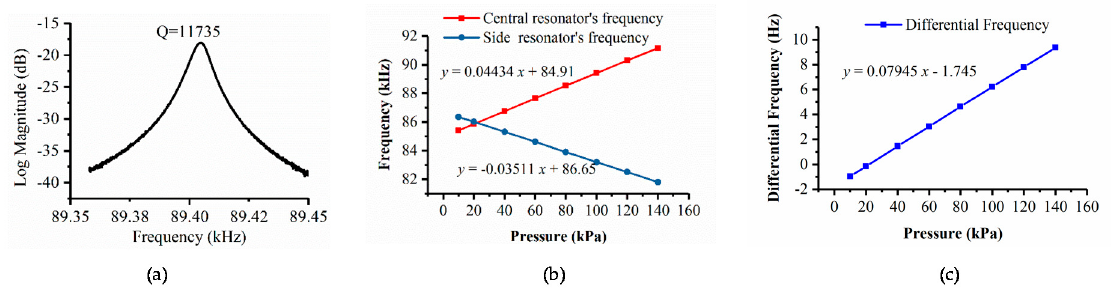
Figure 3. ( a ) The open-loop result of a typical resonant pressure micro-sensor where the quality factor was quantified as 11735, validating the fabrication process, which can produce an environment of high vacuum for the resonators; ( b ) The closed-loop result of a resonant pressure micro-sensor where the resonant frequencies of the central and side resonator were observed to increase and decrease, respectively, in response to an increase in the pressure under measurement; ( c ) The differential output of the resonant pressure micro-sensor, producing a sensitivity of 79.45 Hz/kPa, a linearity less than 0.01%, and a detection range of 10–150